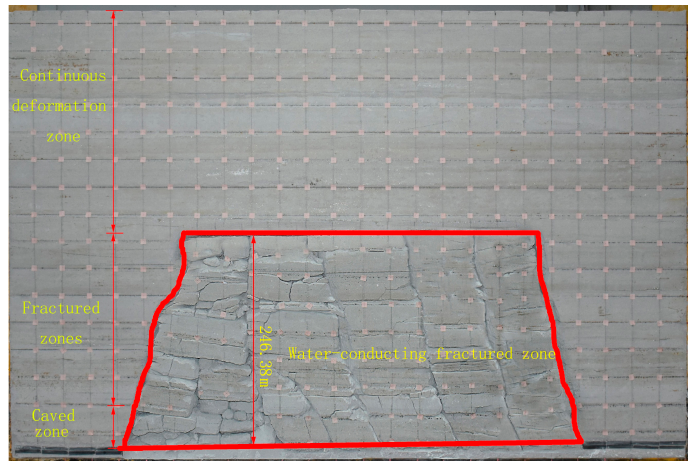
Figure 9. Rock mass failure as the working face moved forward to 510